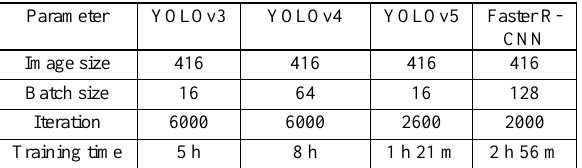
Table 1 . The training parameters.